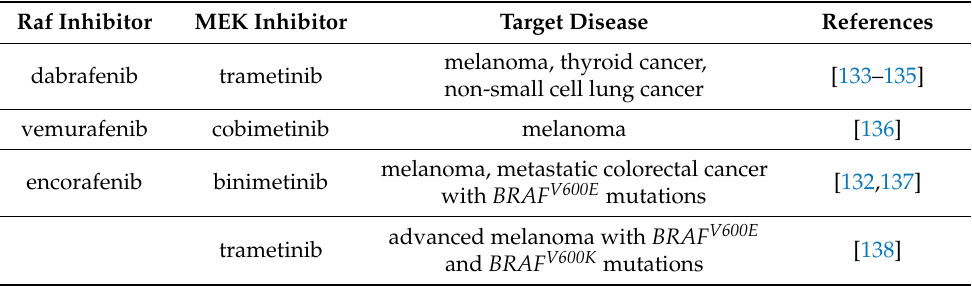
Table 2. Overview on FDA-approved combined or single-agent MEK inhibitor treatments. Raf